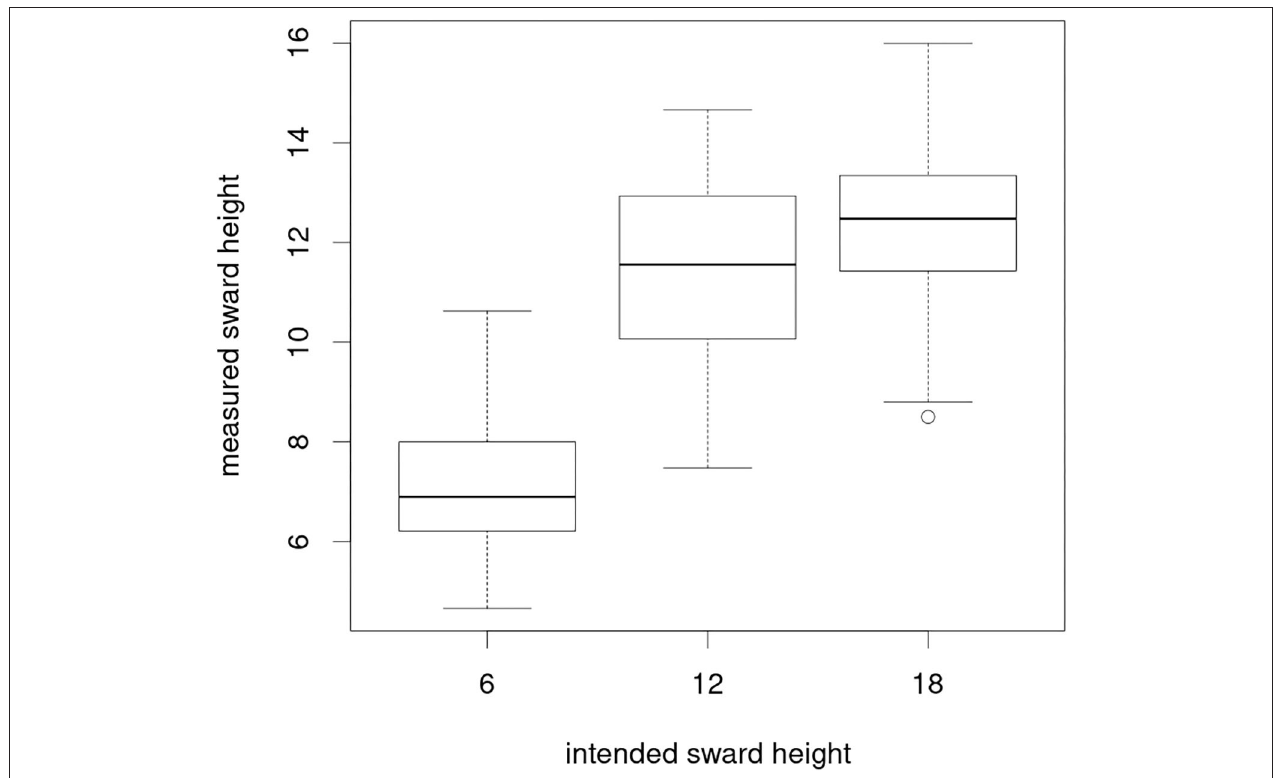
FIGURE 6 | Measured (mean of 50 measurements per paddock taken every 2 weeks) against realized sward heights per grazing intensity across all study